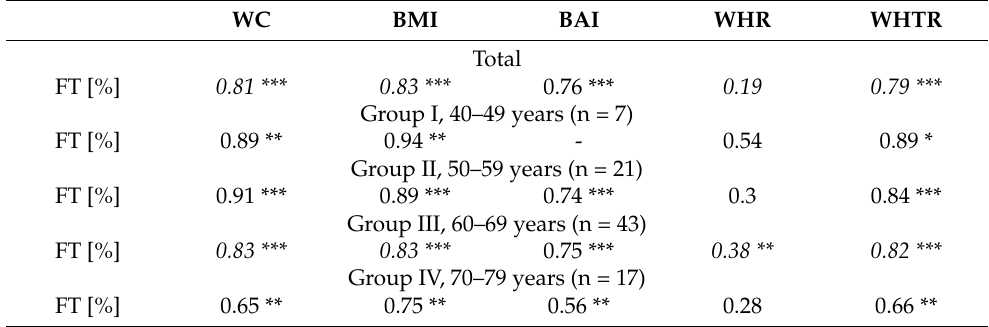
Table 2. Correlations of FT with indicators of obesity.